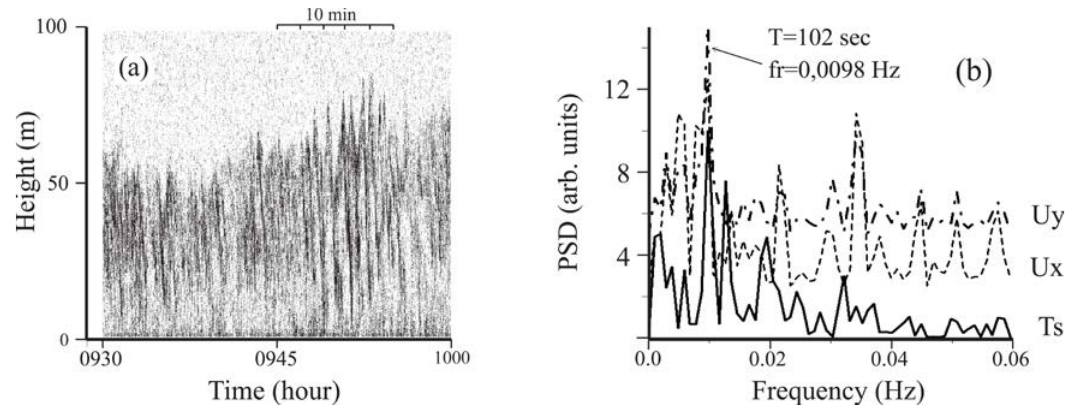
Figure 3 . Sodar echogram for February 5, 2012 (0930 to 1000 LST) (a); Power Spectral Density (PSD) of the horizontal wind components (Ux, Uy) and sonic temperature ( minutes interval (the scale is given in arbitrary